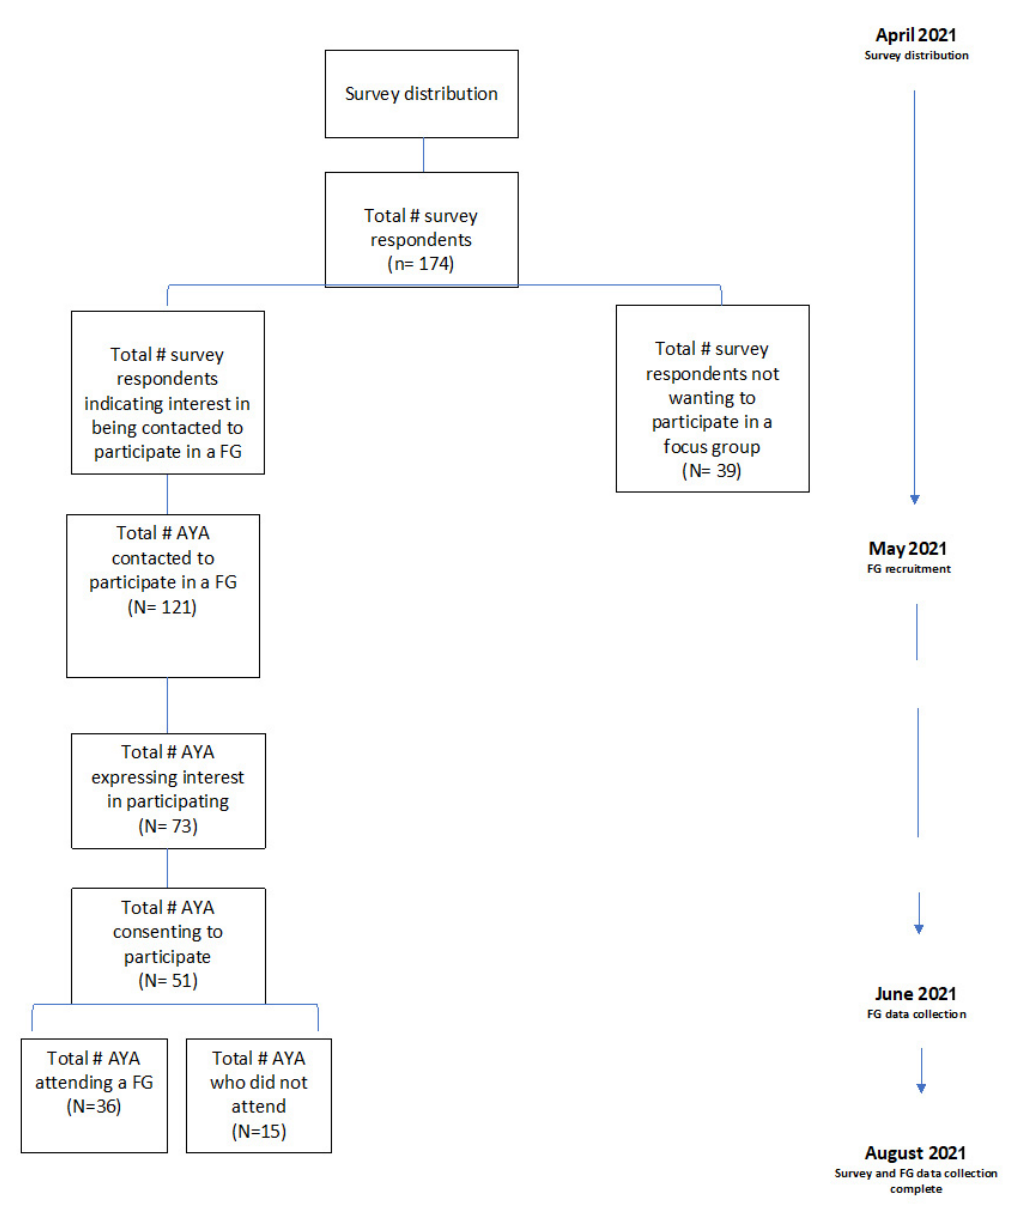
Figure 1. Participant recruitment flow